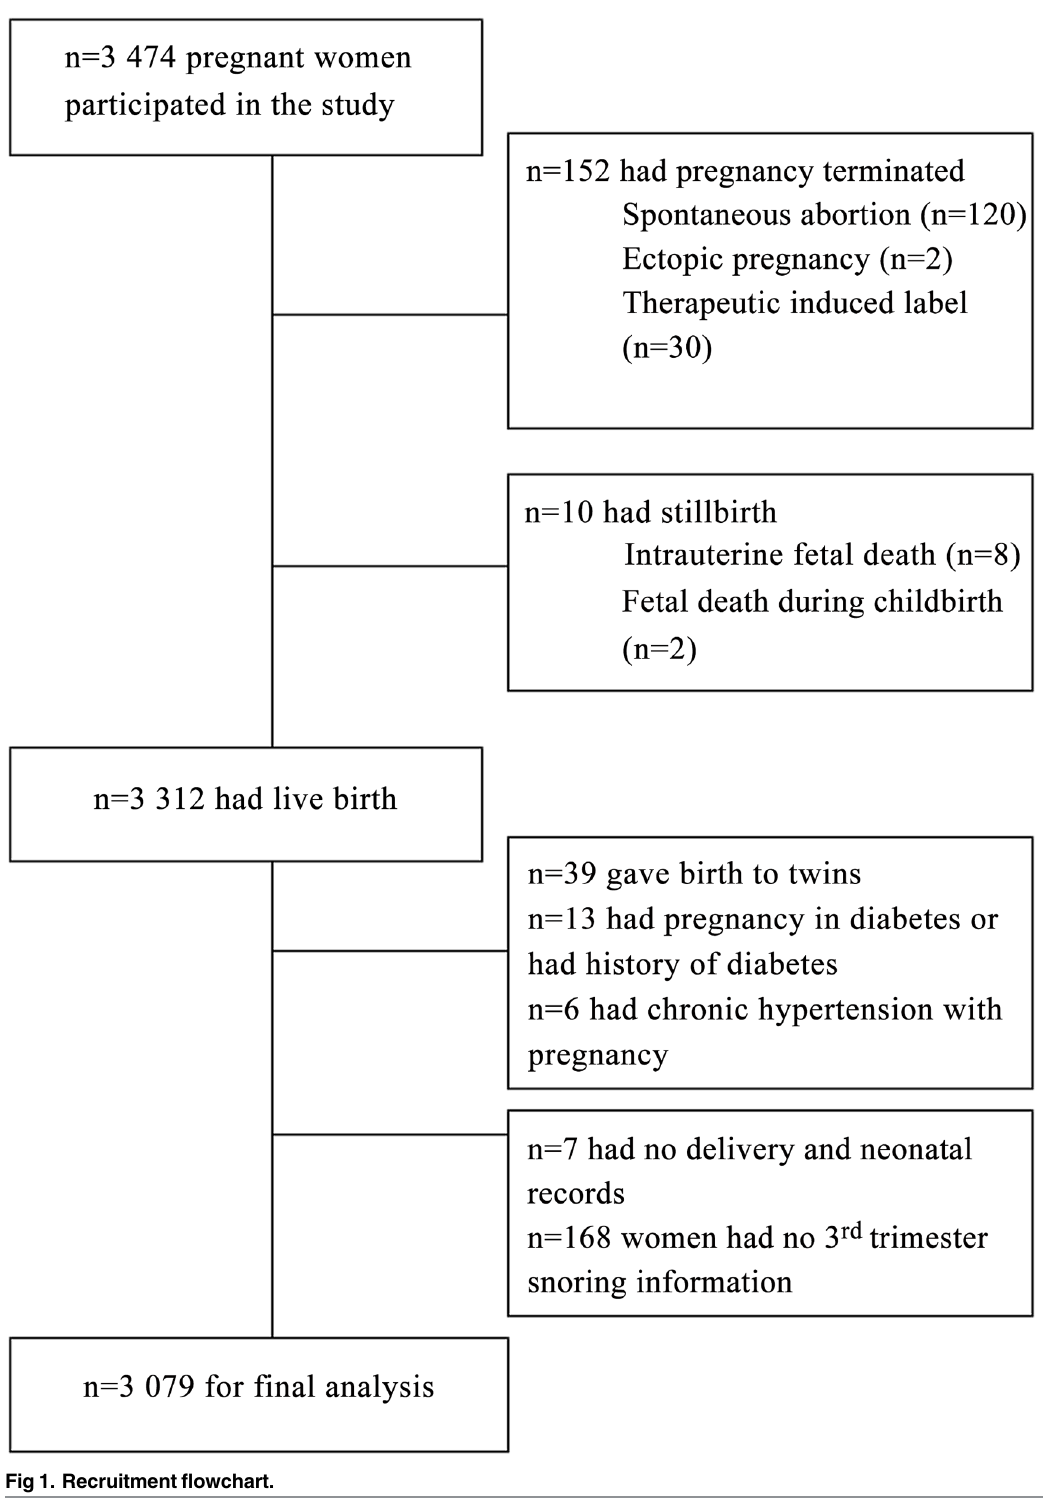
Fig 1. Recruitment flowchart.